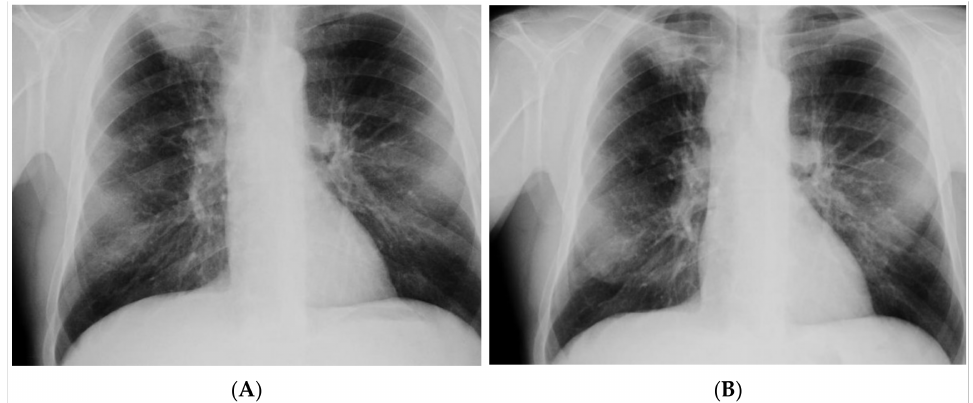
Figure 2. ( A )—X-ray of the chest taken on 29 July 2021 (after 2 months of treatment)—irregular infiltra- tion in the upper right field; ( B )—12 October 2021 (after 5 months of treatment)—reduced infiltration.